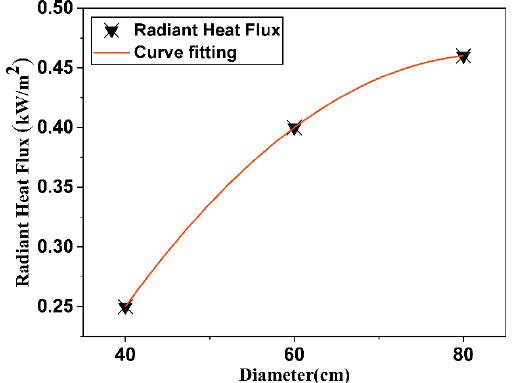
Figure 13. The radiant heat fl ux fi tt ing curve with di ff erent diameters.